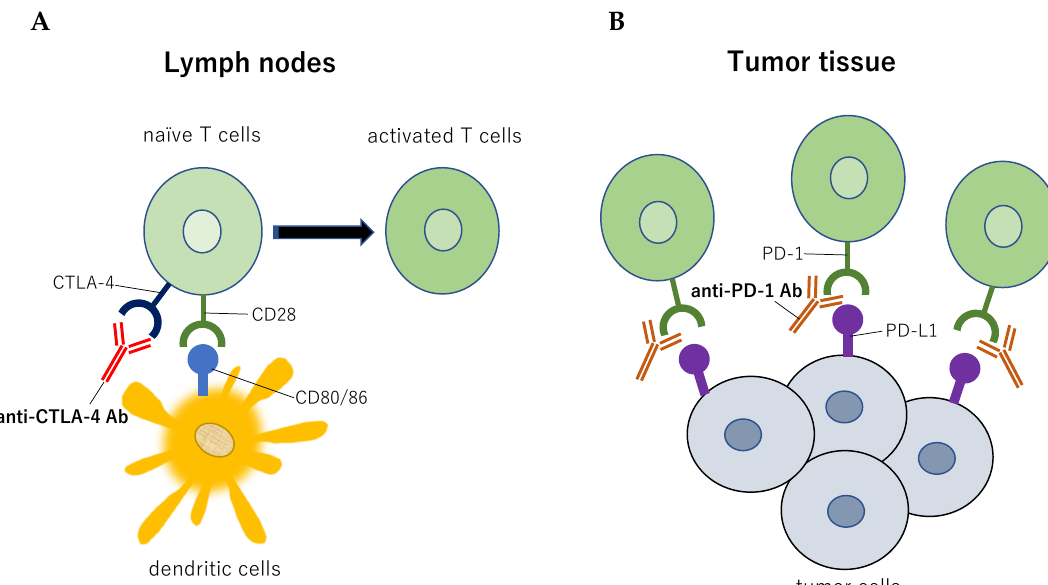
Figure 1. Targets of immune checkpoint inhibitors. ( A ). Sensitization phase. When anti-CTLA-4 antibody binds to CTLA-4, the inhibitory effect on T cells is suppressed. Consequently, effector T cells are induced. ( B ). Effector phase. PD-1 blockade reverses immune evasion mediated by the interaction of PD-1+ immune cells and PD-L1+ tumor cells. CTLA-4, cytotoxic T-lymphocyte-associated protein 4; PD-1, programmed cell death-1; PD-L1, programmed cell death-ligand 1.